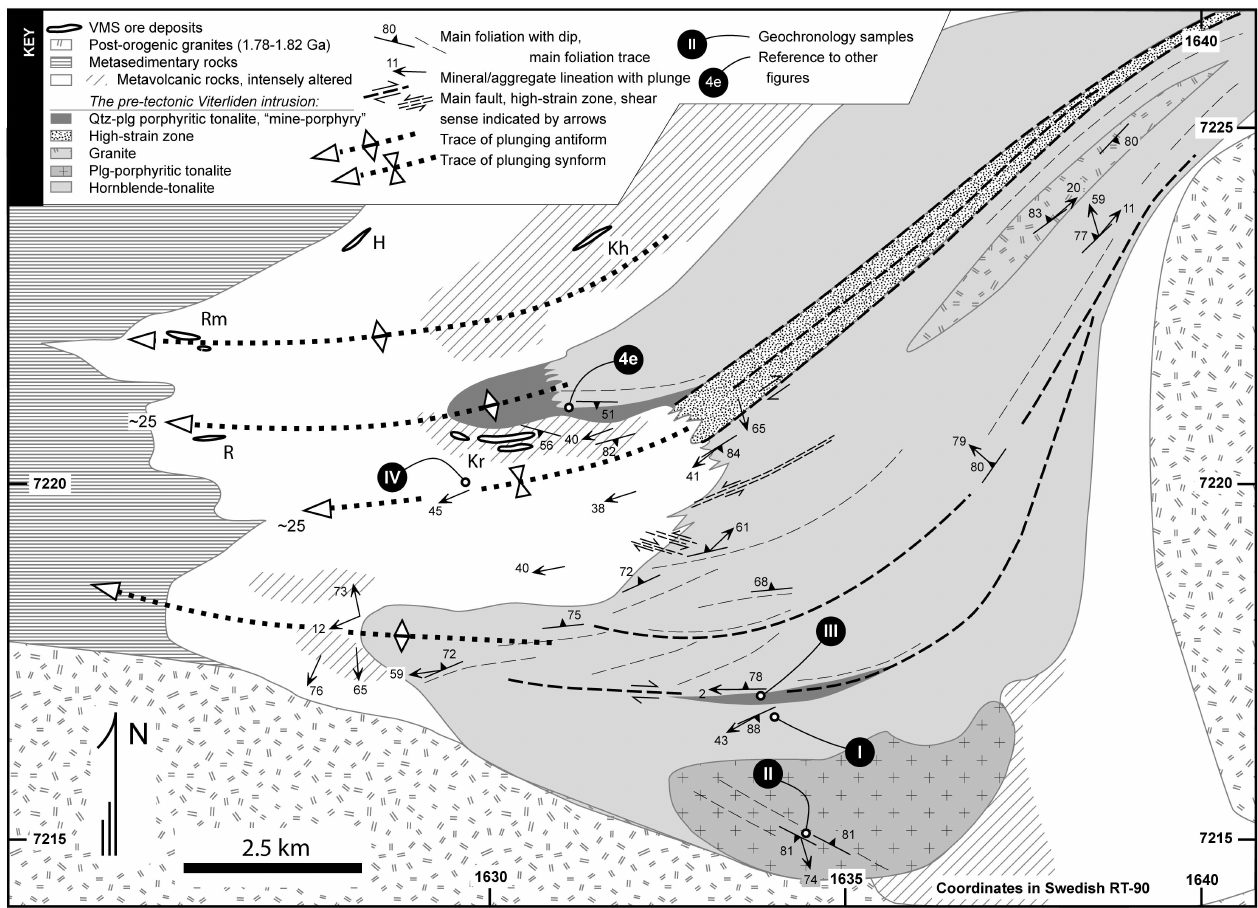
Fig. 2. Geological map of the Viterliden intrusion with locations for the geochronology samples. Modified after Skytt¨a et al. (2010). Ore deposits: Kr=Kristineberg, Kh=Kimheden, H=Horntr¨ask, Rm=R¨avlidmyran,